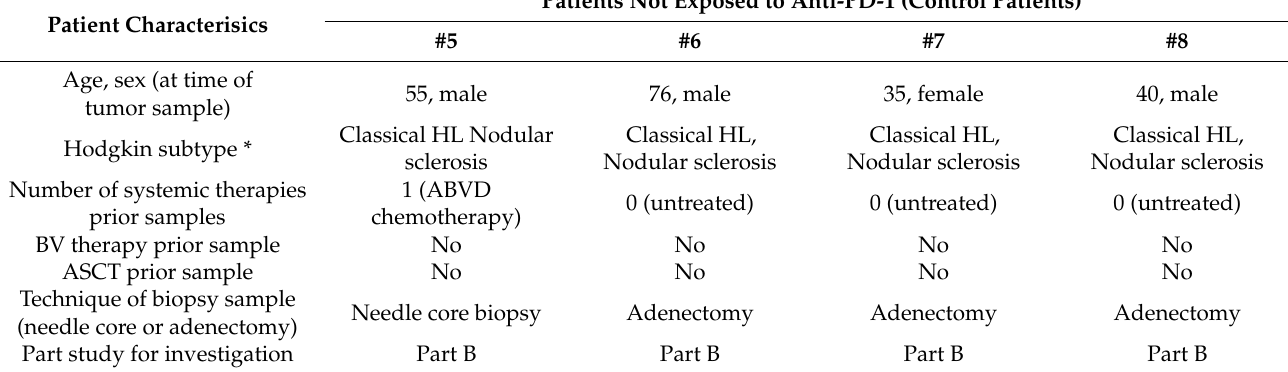
Table 2. Main clinical characteristics of control patients not exposed to anti-PD-1 with classical Hodgkin lymphoma included in the